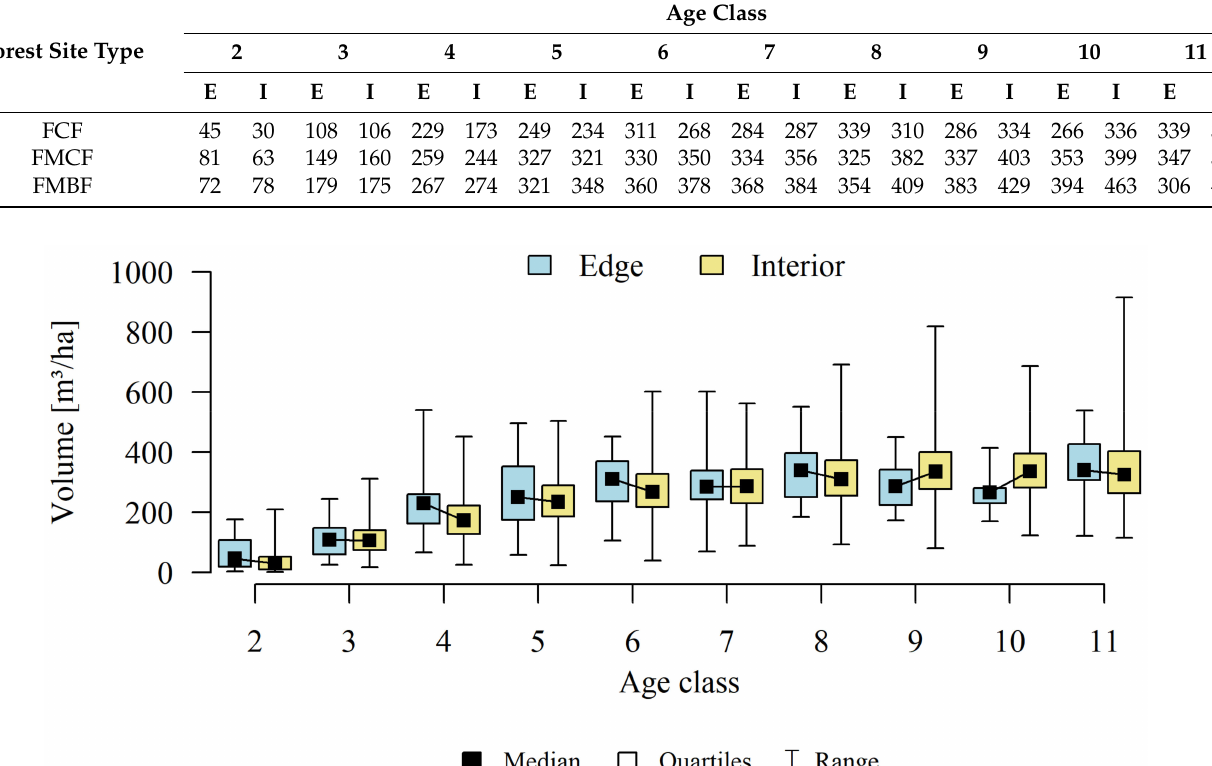
Figure 3. Results of statistics calculated for the growing stock volume density of pine stands on the FCF site, divided into the edge and interior zone.